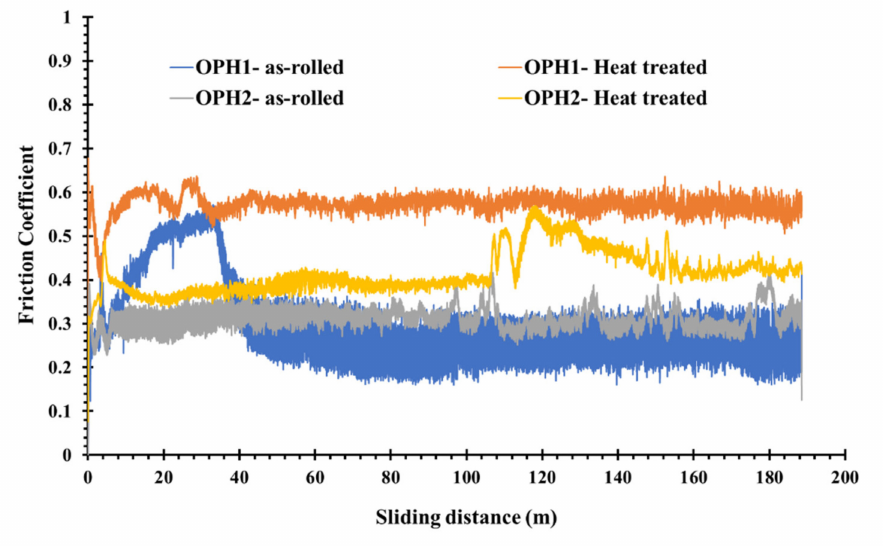
Figure 10. Friction coe ffi cient vs. sliding distance during the pin-on-disk